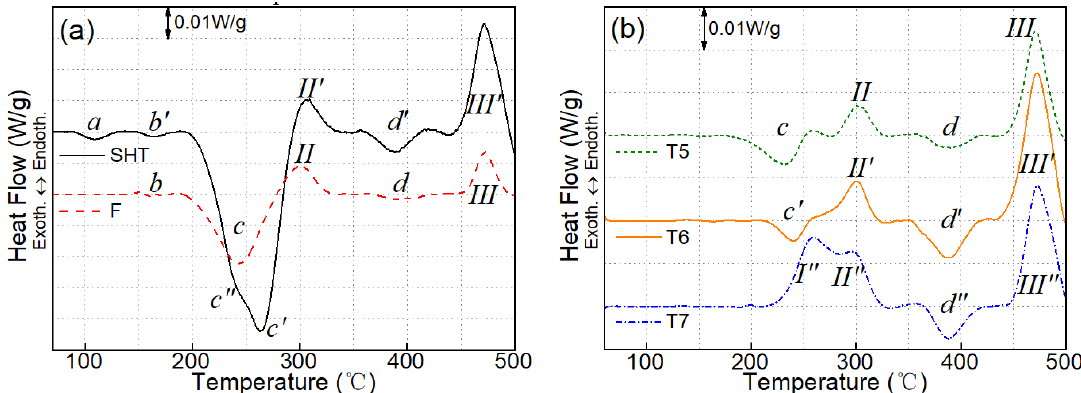
Figure 6. DSC heating curves of the Al-Si-Cu-Mg 319 alloy subjected to different treatments: ( a ) F and SHT; ( b ) T5, T6, and T7. Table 4. Summary of DSC characterization of the tempers of the Al-Si-Cu-Mg 319 alloy. Exo. Peak a Temper